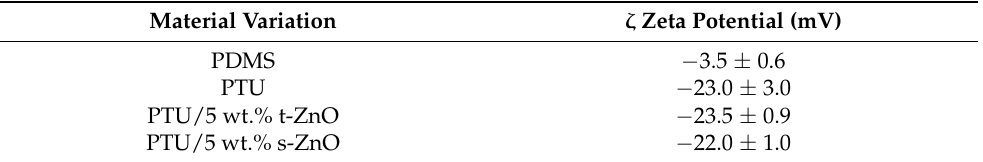
Table 4. ζ -Potential after 1 h immersion in KNO 3 10 − 3